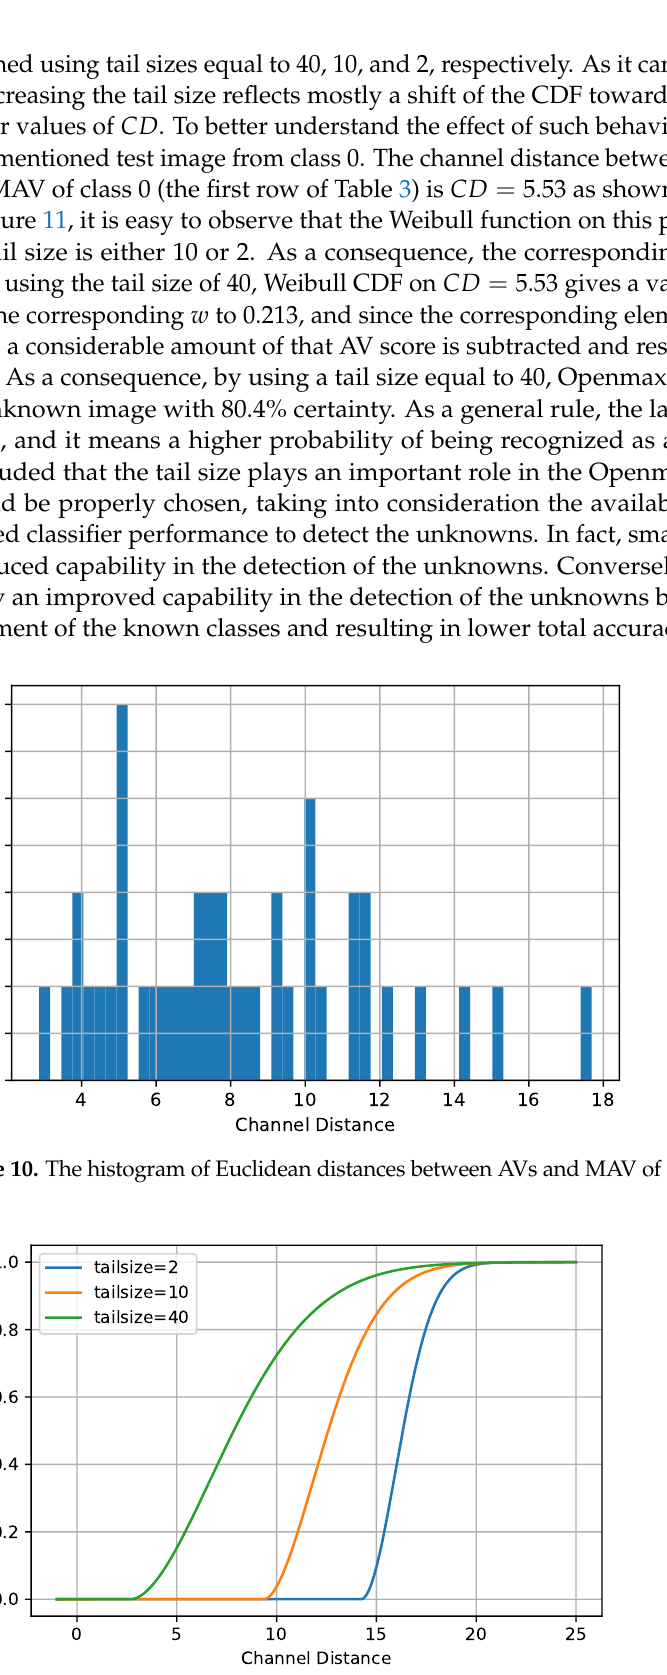
Figure 11. CDF of Weibull function fitted to η = 2, 10, 40 largest distance values between AVs and MAV of the class zero in the training